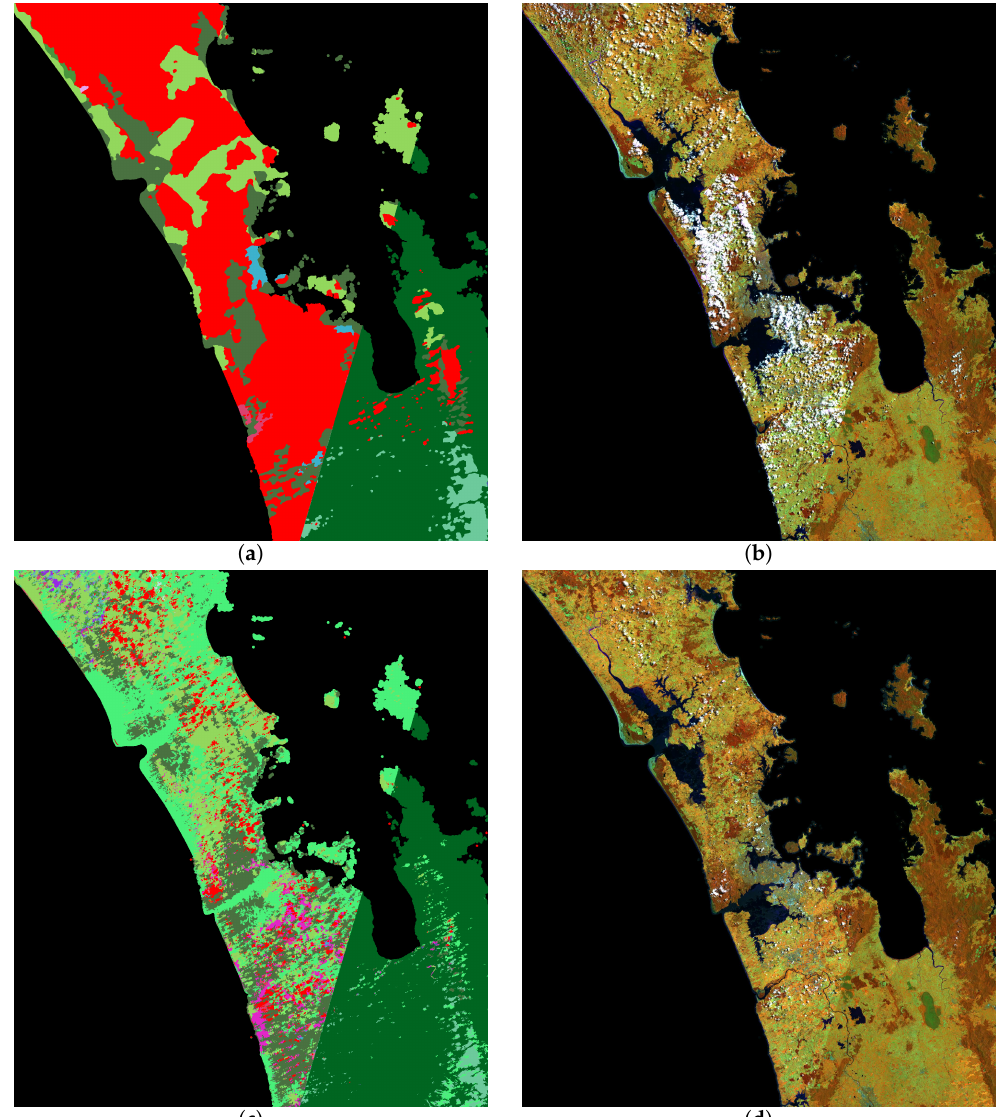
Figure 6. Comparison of control masks and subsequent mosaics for the summer of 2015/16 in the Auckland area. Panels ( a , b ) show the result for manual cloud/cloud-shadow detection. Panels ( c , d ) show the result for automated cloud/cloud-shadow detection. Panels ( a , c ) are control masks where the colours represent the image date used for the mosaic and red is remaining